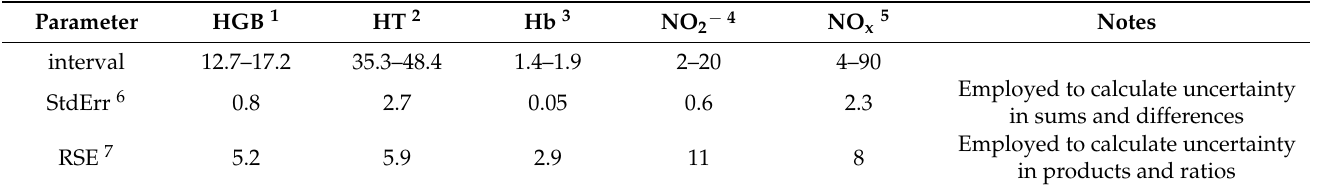
Table A1. Representative values of parameter interval, standard error, and relative standard error of the parameters used for the calculation of the extended